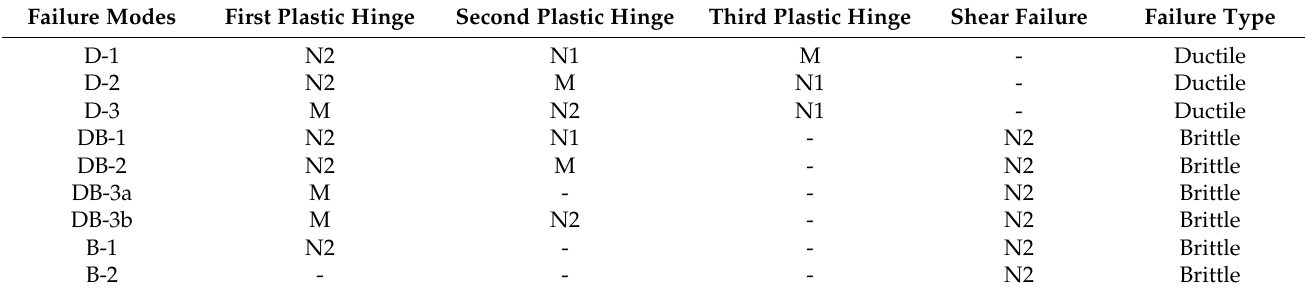
Figure 3. The failure regions are described considering the relationship between the shear limit and moment limit of the slab sections. Table 1. Summary of different failure modes for the end span of an RC